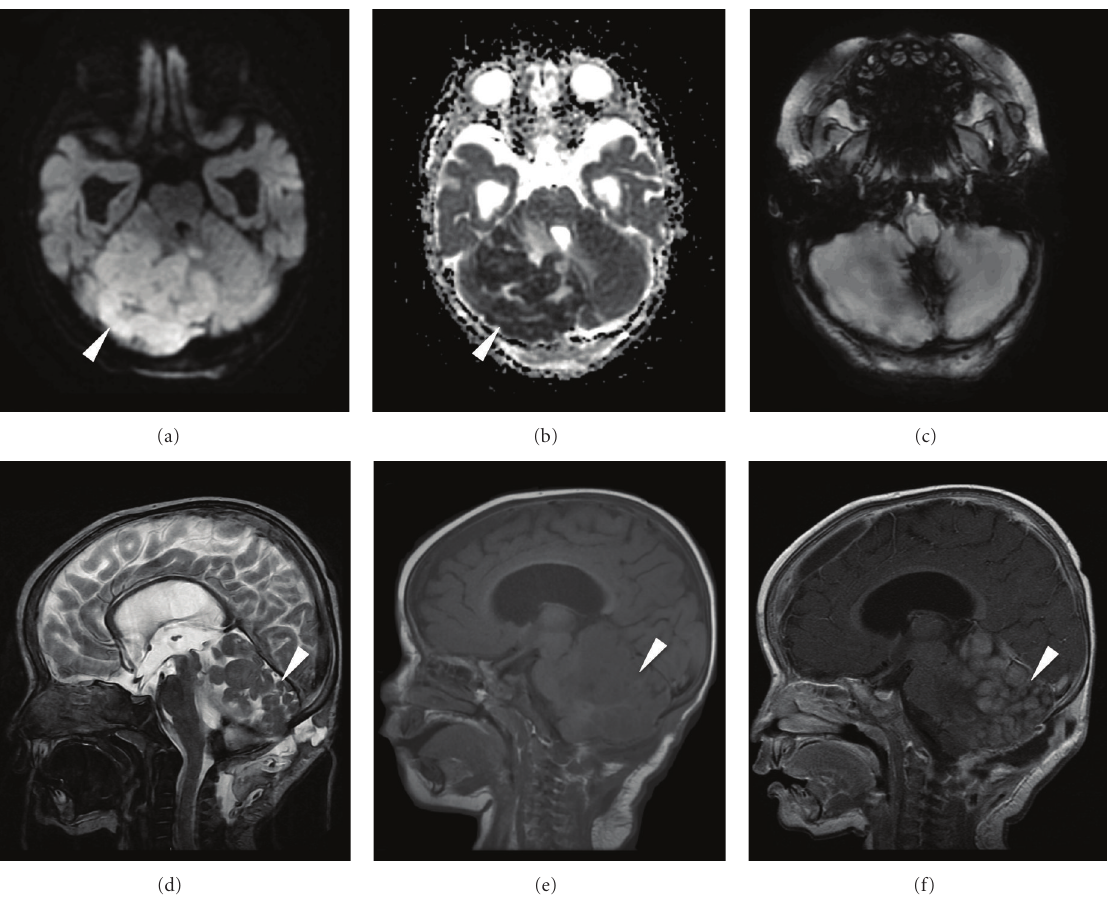
Figure 1: MRI features of medulloblastoma with extensive nodularity: (a)–(c) axial sequences reveal a posterior fossa mass (arrows) with decreased di ff usivity on DWI (a) and ADC sequences (b), without specific intratumoral abnormalities on SWI sequence aside from amorphous susceptibility artifact present along the vermis from prior surgical biopsy (c). Sagittal sequences reveal extensive nodularity on T2 (d) and postgadolinium (f) sequences that is less evidence on precontrast T1-weighted sequences where the nodular areas appear more hypointense